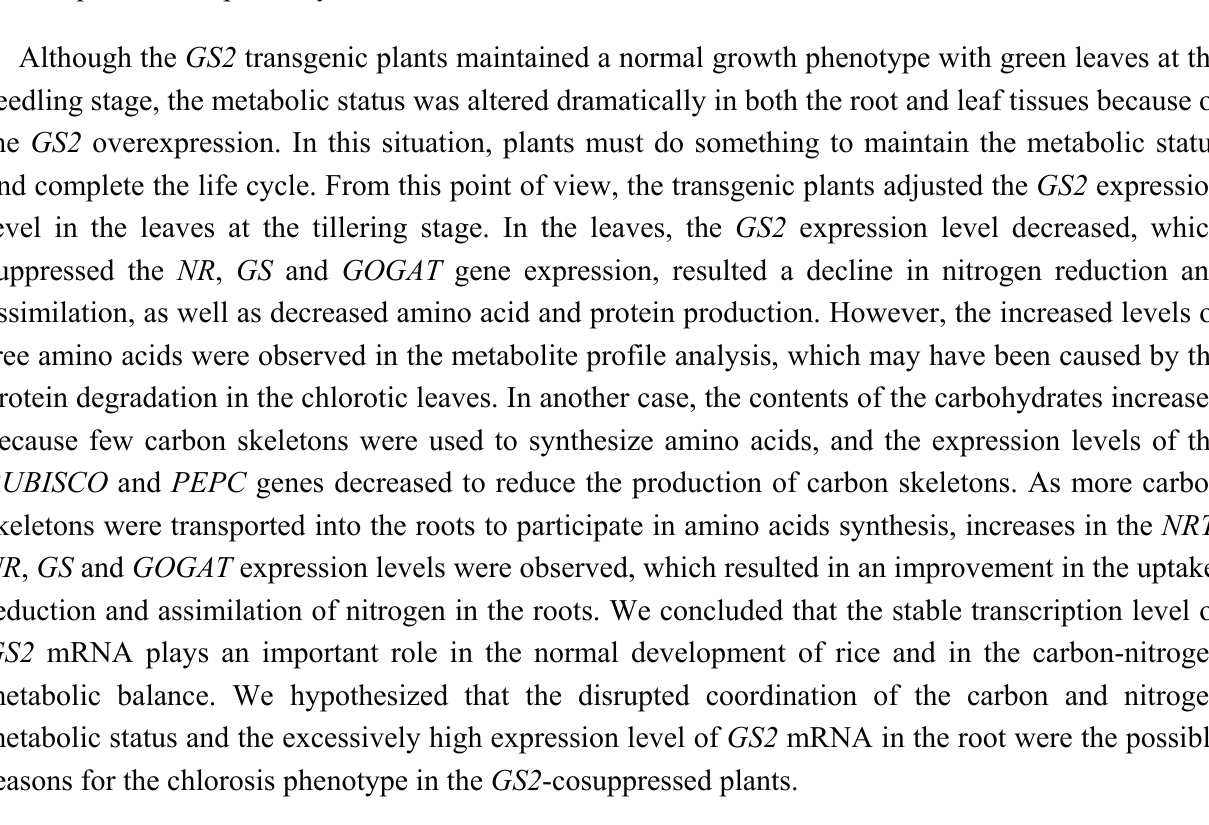
Figure 7. Summary of the differences between the seedling stage and the tillering stage in the GS2 transgenic plant. The symbols ↑ and indicate induction and repression,